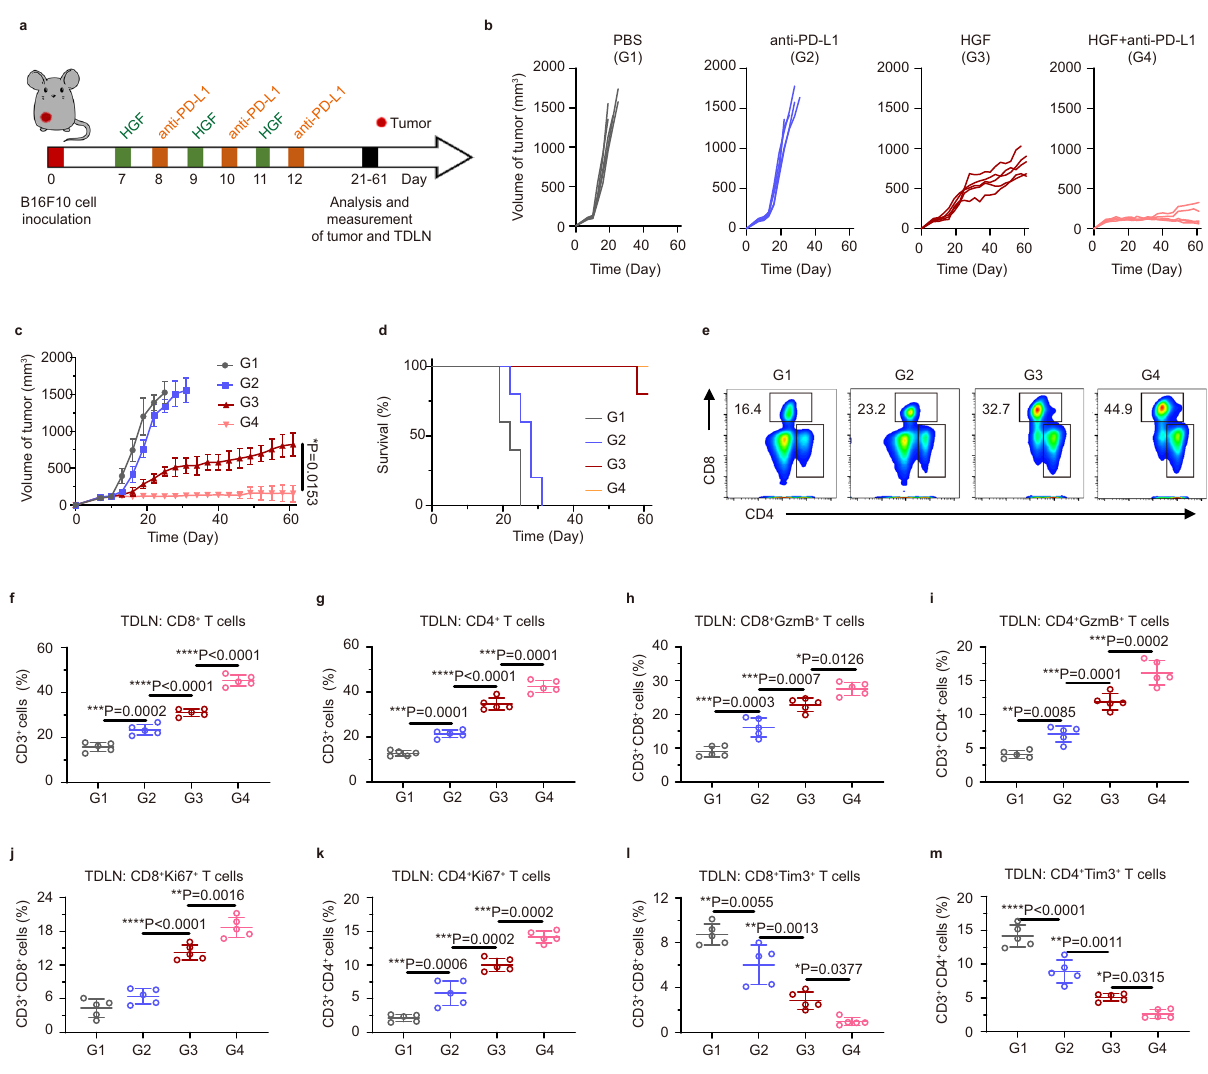
Fig. 6 In vivo therapeutic impetus of HGF to PD-L1 checkpoint inhibitor therapy. a Schematic illustration of the experiment design to assess the tumor inhibition and the immune responses as triggered by PBS, anti-PD-L1, HGF or HGF + anti-PD-L1 on subcutaneous B16F10 tumor model. G1, PBS; G2, anti- PD-L1; G3, HGF; G4, HGF + anti-PD-L1. b and c Tumor growth curves during treatment. d Survival rates of different groups over time. e – g Flow cytometric plots and quanti fi cation of e CD8 + and f CD3 + g T cells, among CD3 + T cells in the TDLN. h – m Flow cytometric quanti fi cation of GzmB + cells ( h – i ), Ki67 + cells ( j and k ) and Tim3 + cells ( l and m ) in CD8 + and CD4 + T cells. Data were presented as mean ± SD. n = 5 biologically independent animals per group. Statistically signi fi cant differences between groups were identi fi ed by one-way ANOVA with Tukey ’ s post hoc test. * P < 0.05, ** P < 0.01, *** P < 0.001, and **** P <